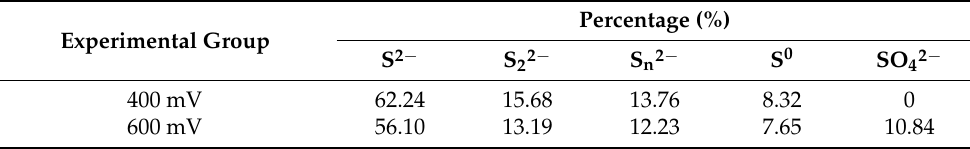
Table 2. XPS test results of the leaching residue.